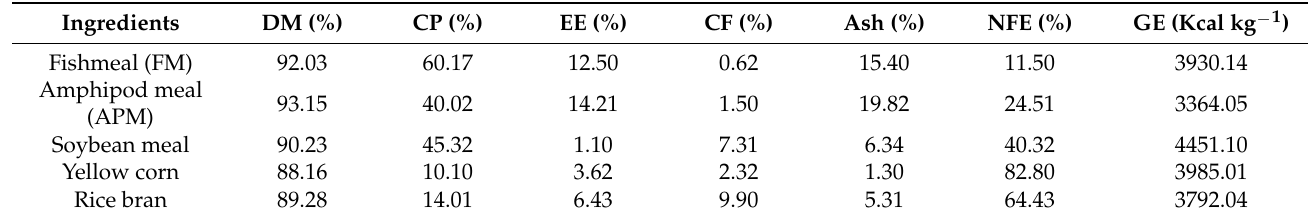
Table 1. Proximate biochemical compositions of the ingredients used in formulating the experimental diet (% of dry matter). Ingredients